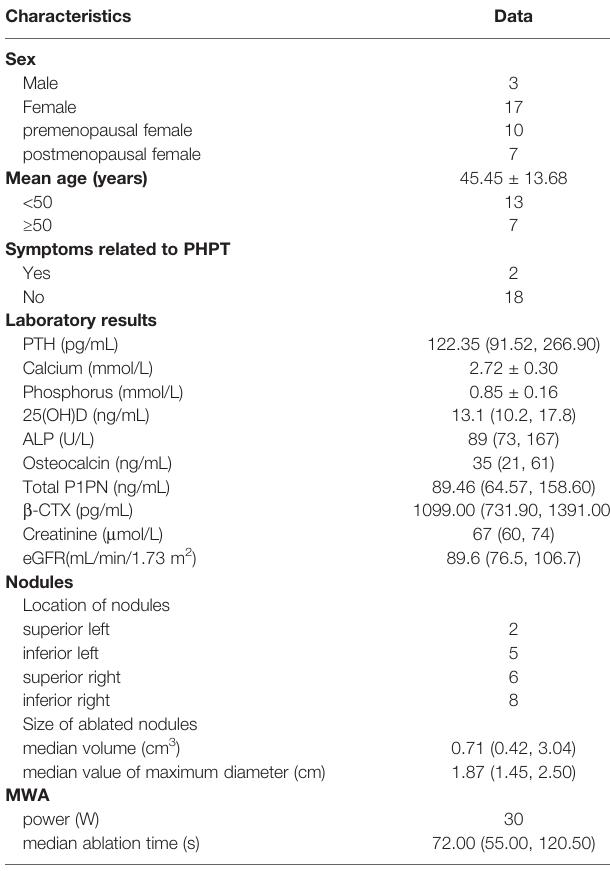
TABLE 2 | Baseline characteristics of patients with